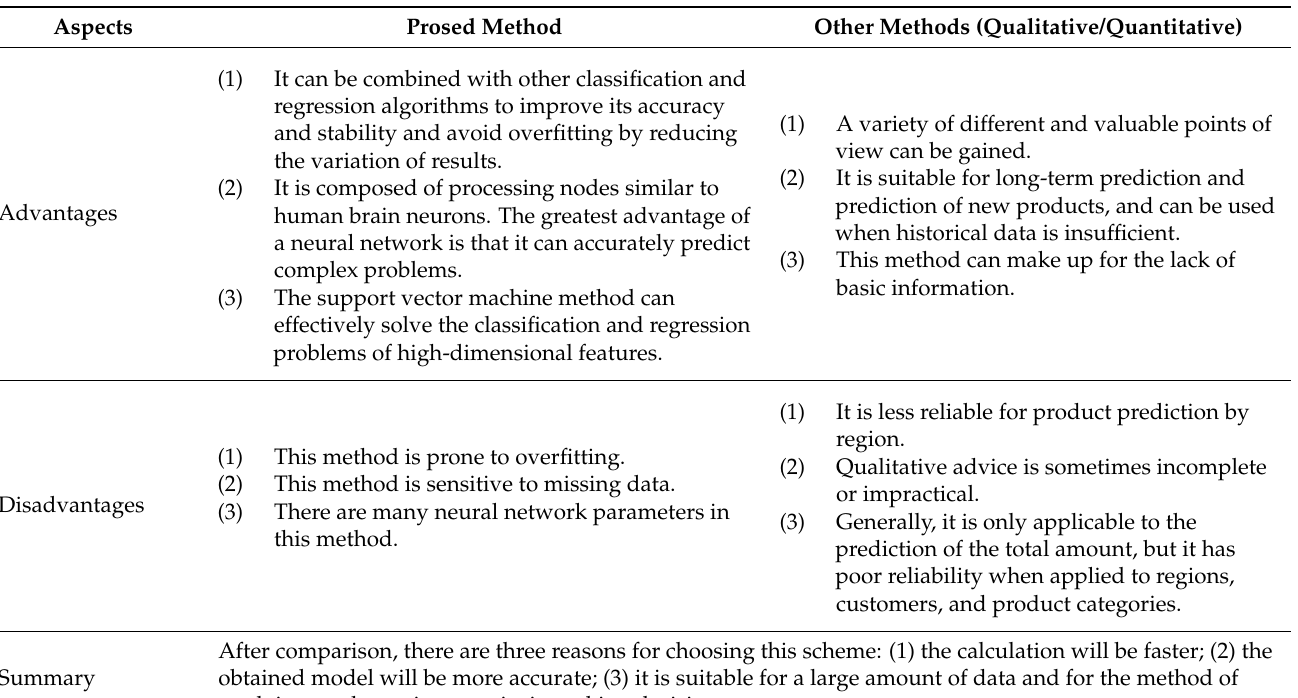
Table 1. Comparison of the advantages and disadvantages of the proposed method and other model